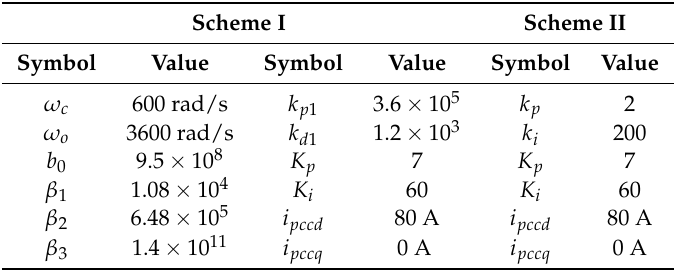
Table 4. Controller